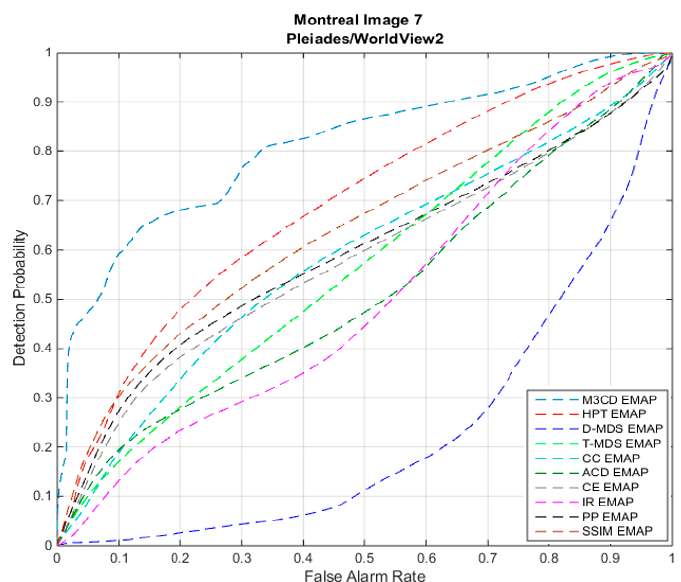
Figure 20. ROC curves for Image Pair-5 with EMAP. Table 6. AUC values and differences between single band and EMAP cases for dataset-5. Bold numbers indicate the best performing method in each column.